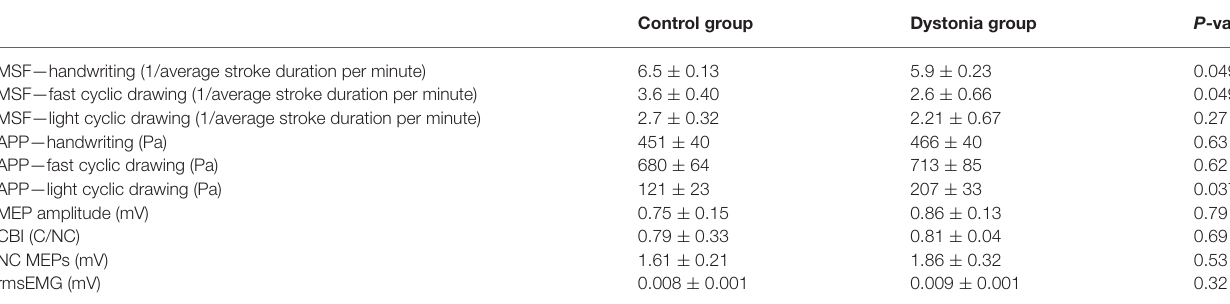
TABLE 2 | Comparison of groups at baseline from data averaged across the three sessions .